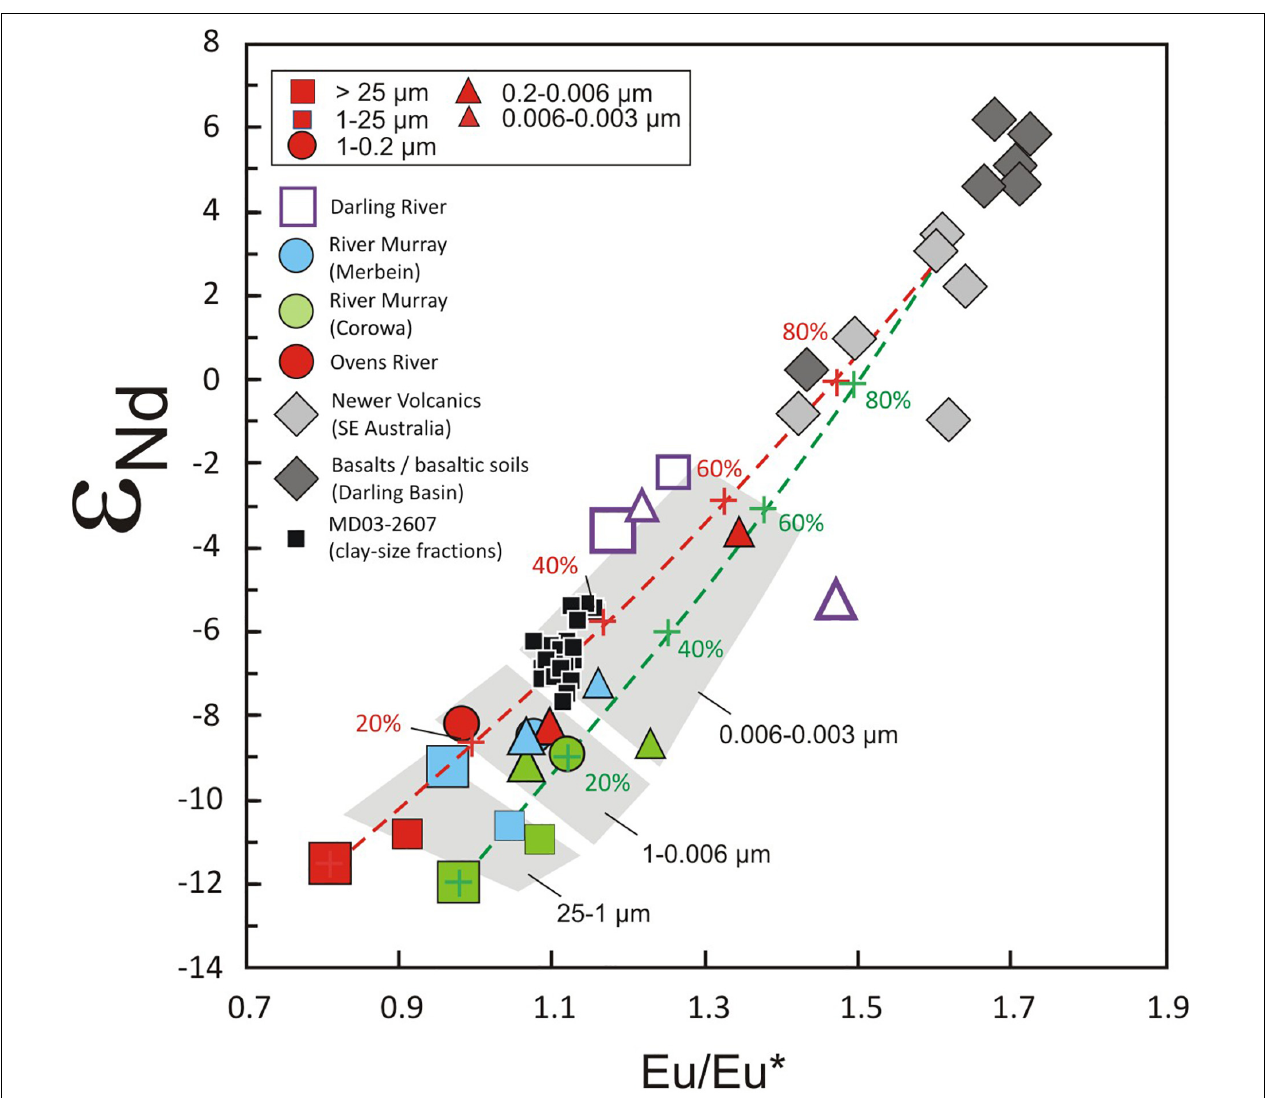
FIGURE 6 | Relationships between 143 Nd/ 144 Nd (expressed as ε Nd ) and Eu-anomalies (Eu/Eu*) in rocks, soils and suspended particulates from the Murray-Darling Basin, and inferred mixing model between Paleozoic granitoid and Tertiary volcanic sediment sources. The coarse-grained ( > 25 µ m) fractions of the suspended loads were assumed to be representative of the local “granitoid” end-member in each of the studied sub-catchments of the River Murray. The “volcanic” end-member was determined using a compilation of REE and Nd isotopic data for various basalts and basaltic soils from the Darling River basin (Martin and McCulloch, 1999) and the Newer Volcanics in SE Australia (McDonough et al., 1985). The dotted lines correspond to the resulting mixing lines that are used to graphically estimate the relative percentage contribution of volcanogenic material in each size-fraction. Also shown are the data for the studied marine sediment